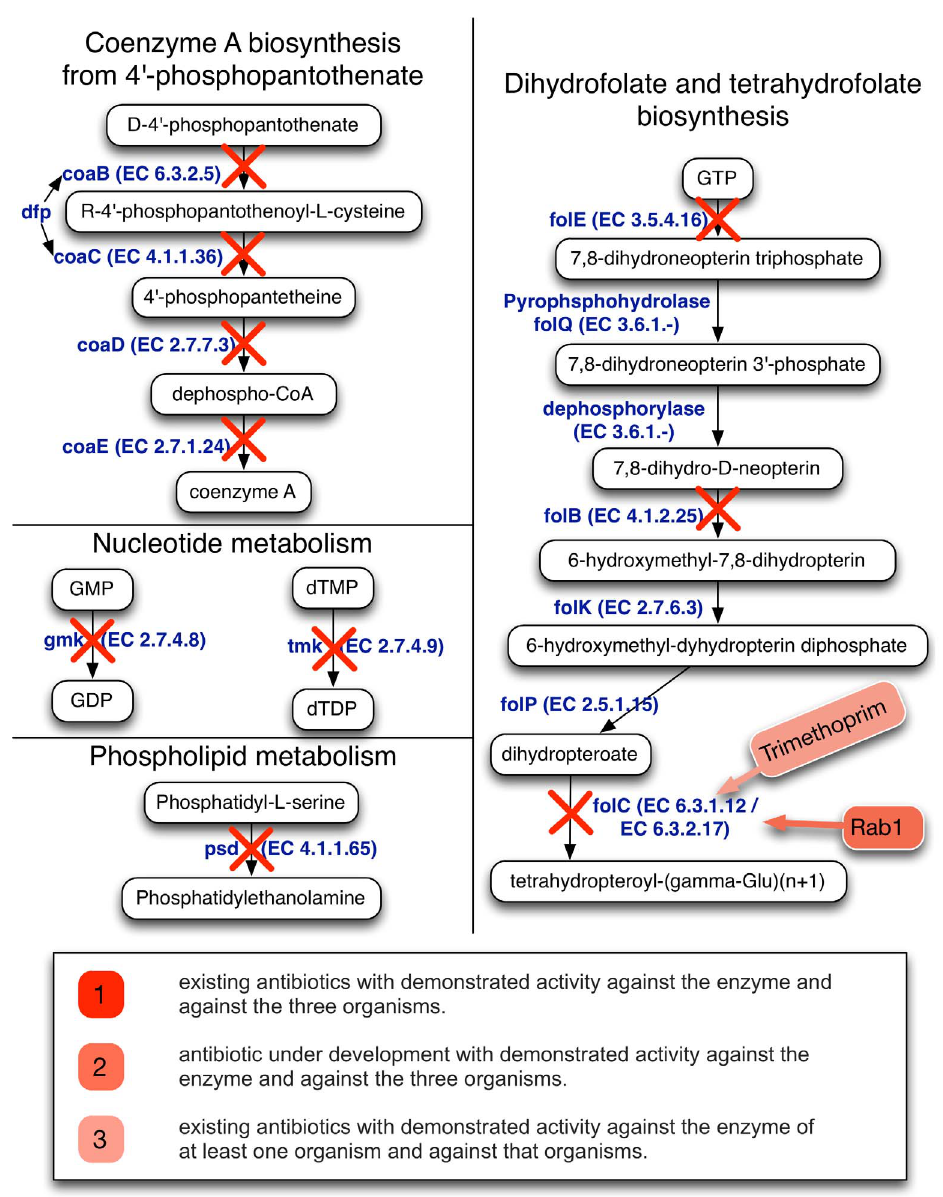
Figure 1. Common metabolic enzyme targets in the three Category A bacteria. Nine shared essential enzymes in several major pathways were identified across all Category A bacteria and are marked by